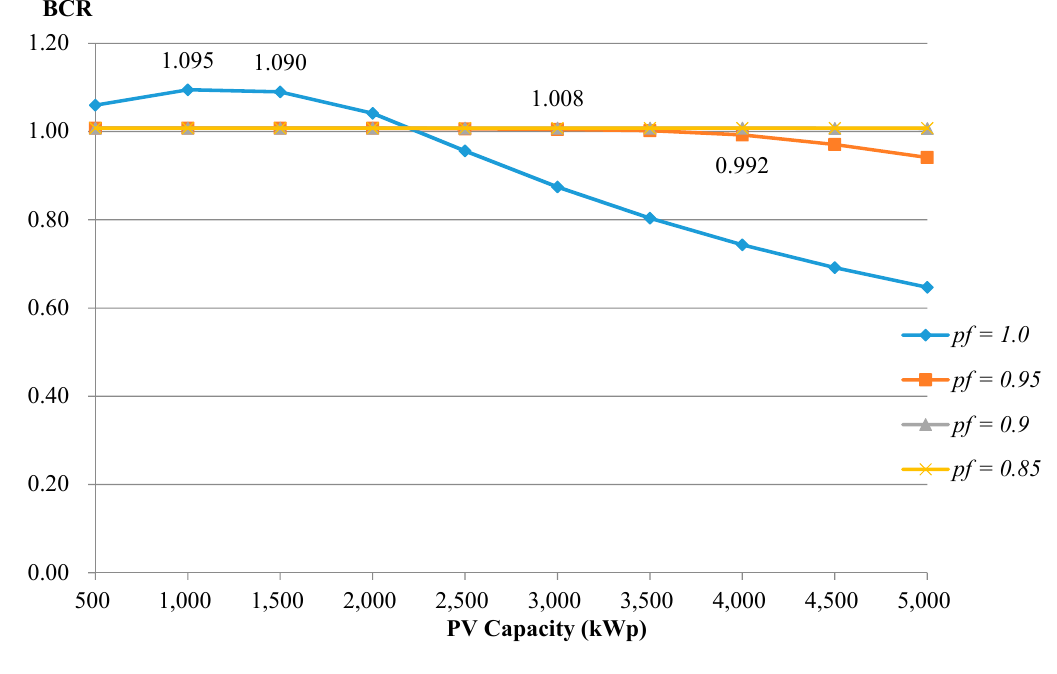
Figure 10. BCRs for control abilities pf = 1.0, 0.95, 0.9, and 0.85; BCR: benefit-cost ratio.